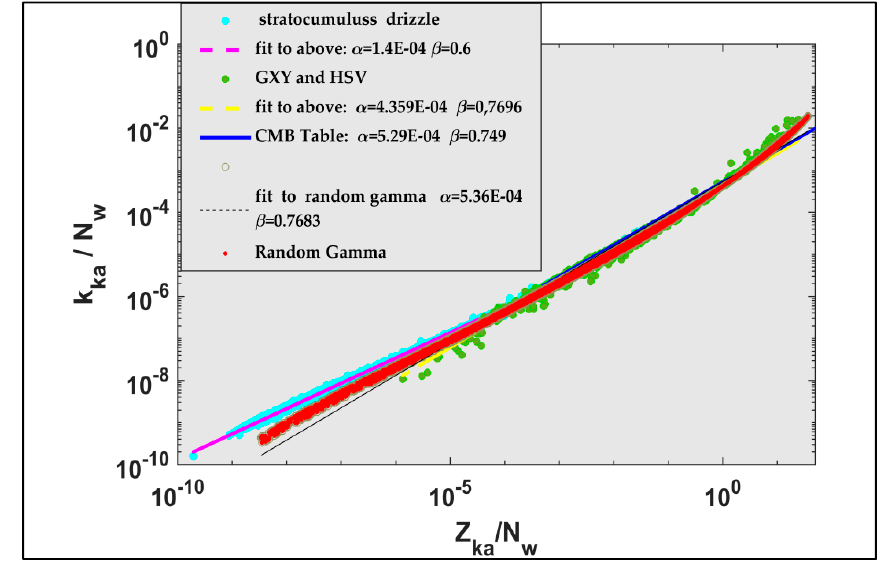
Figure 13. As in Figure 12 but for Ka-band.